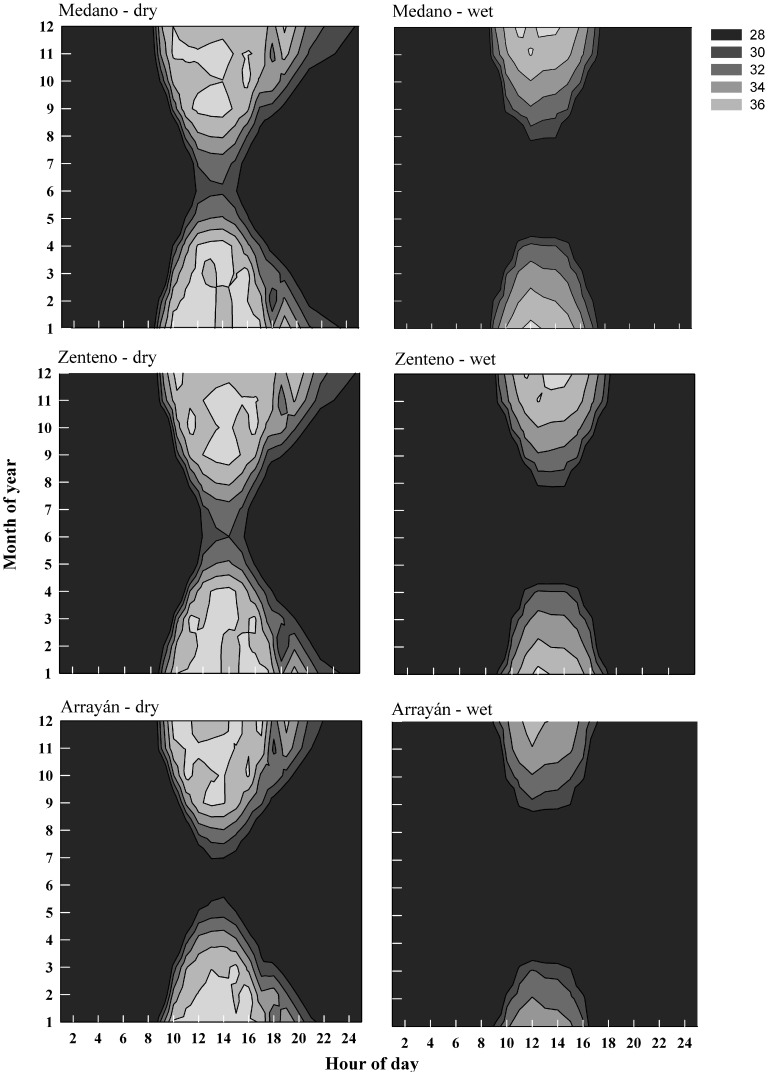
Seasonal and daily activity constraints for Microlophus atacamensis in Medano, Zenteno, and Arrayán, on dry (terrestrial) and wet (intertidal) conditions.Gray contours indicate suitable temperatures (28–36°C) for activity.